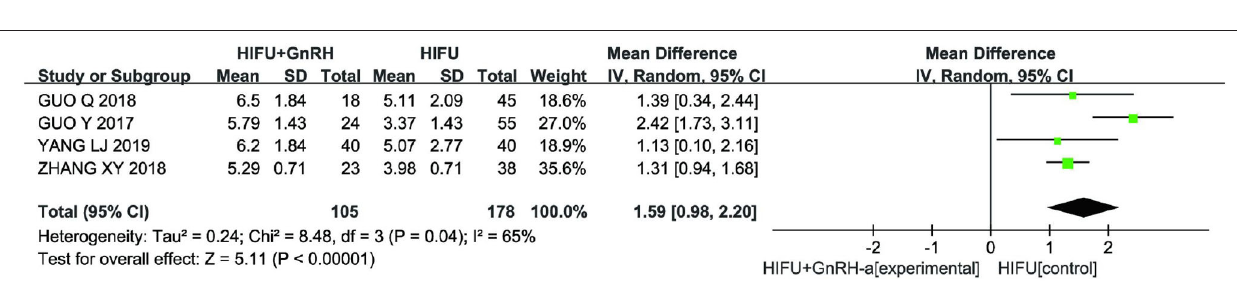
FIGURE 6 | Meta-analysis of visual analog scale (VAS) scores of dysmenorrhea in two groups.